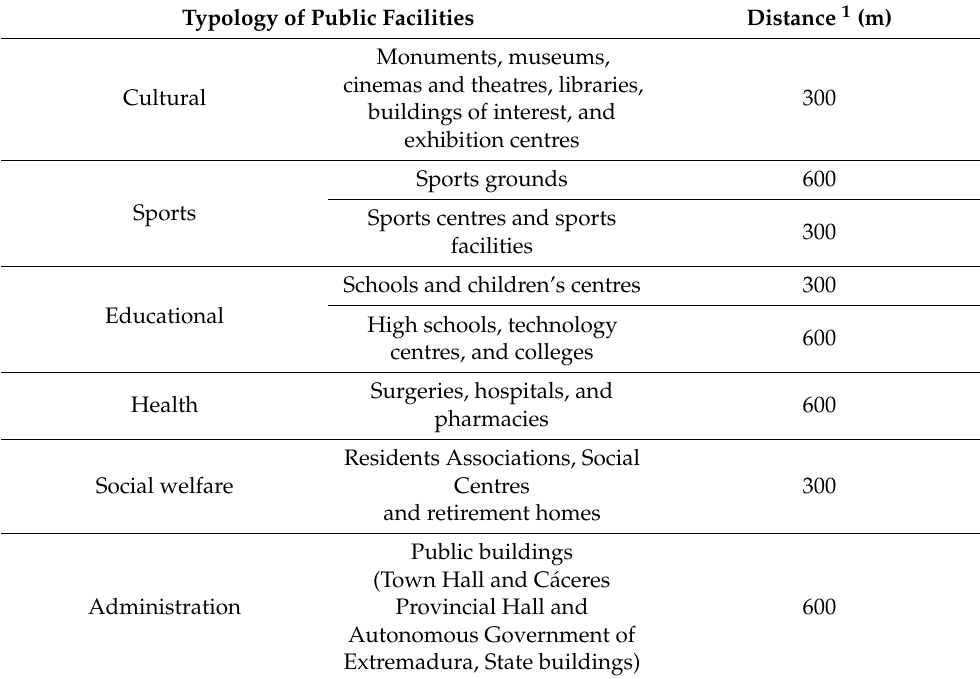
Table 5. Public equipment and